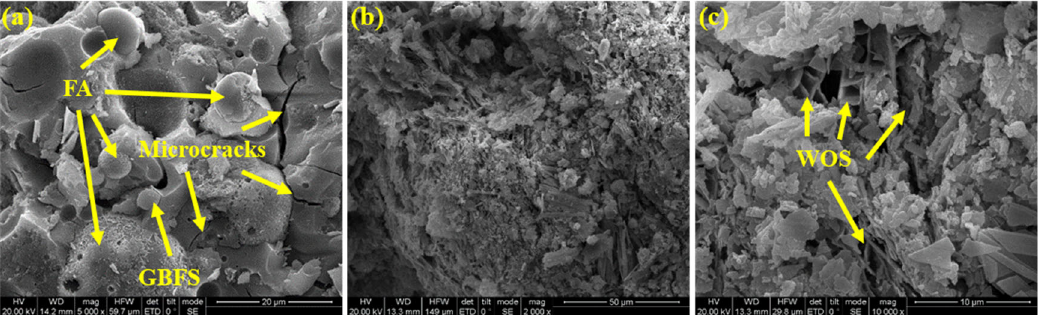
Figure 13. SEM micrographs of geopolymer matrix ( a ), amorphous morphology ( b ), and WOS ( c ).